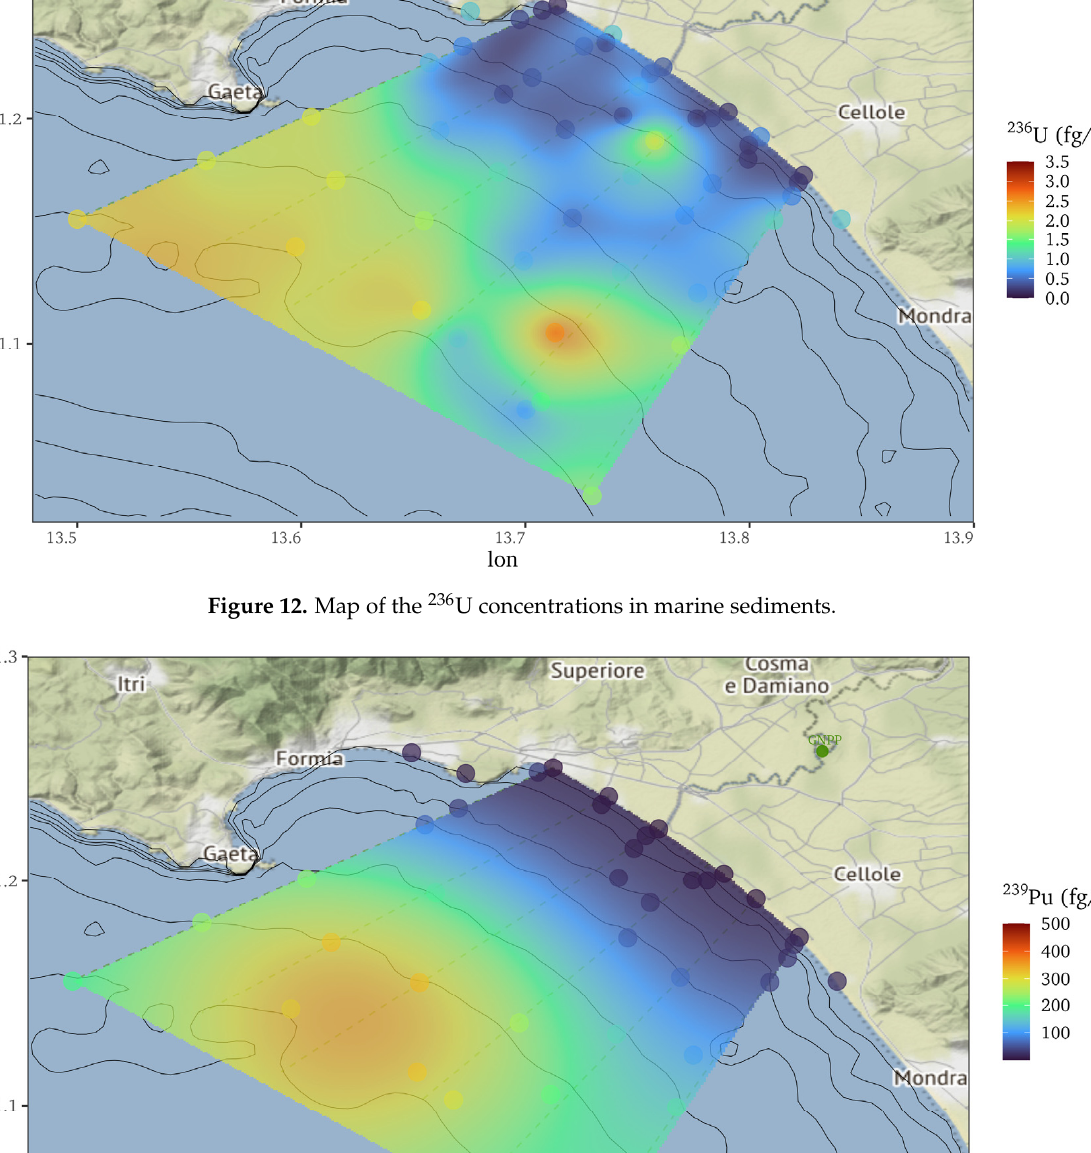
Figure 11. Concentration of 239 Pu (in blue, on the left) and 239/240 Pu isotopic ratio (in red, on the right) in marine sediments. The samples in abscissa are arranged by increasing depth of sampling. Values below the detection limit are not shown.